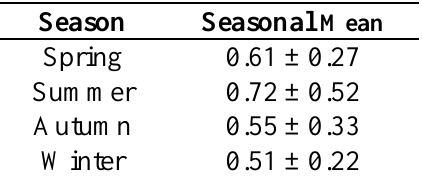
Table A1. The statistics for all of the level 2.0 AOD (550 nm) as observed at the Lake Taihu station.